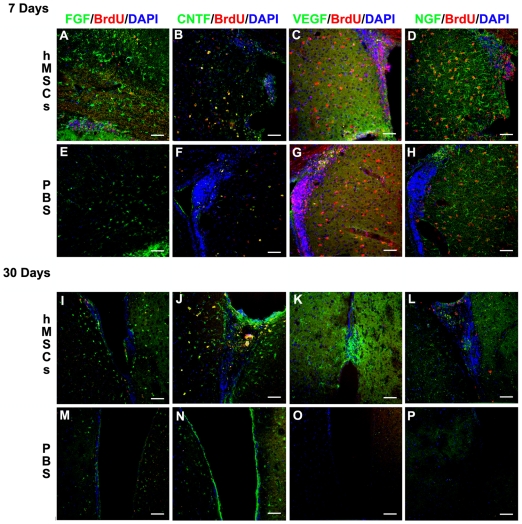
hMSC implantation increased neurotrophic factor signaling.There was a substantial increase in FGF-2 signaling in the hMSC-implanted hemisphere (A, I) compared to the contralateral, PBS-injected hemisphere (E, M) at 7 and 30 days post-implantation. There was no increase in CNTF signaling at 7 days post-implantation (B) compared to the PBS-injected hemisphere (F) although a slight increase was detected by 30 days post-implantation (J compared to N). There was an increase in VEGF signaling in the hMSC-implanted hemisphere at both 7 (C) and 30 (K) days post-implantation compared to the PBS-injected hemisphere (G,O). NGF signaling appeared to be increased similarly in both the hMSC- and the PBS-injected hemispheres 7 days post-implantation (D,H). By 30 days post-implantation, NGF was still slightly increased in the hMSC-implanted hemisphere (L) compared to the contralateral, PBS-injected hemisphere (P). Scale bar = 50 µm.